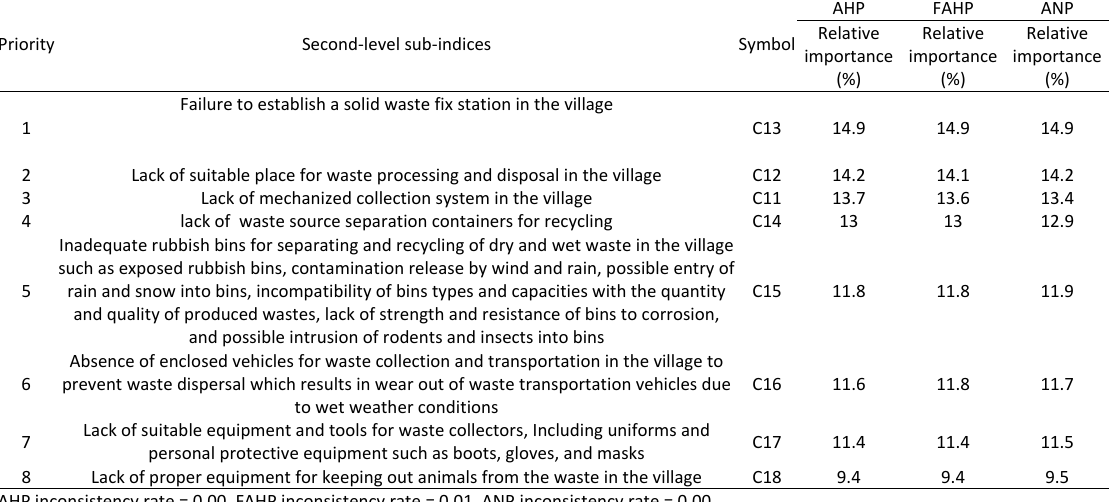
Table 5: Prioritization of weaknesses and relative importance values of the sub-indices of the C1 index based on AHP, FAHP, and ANP Priority